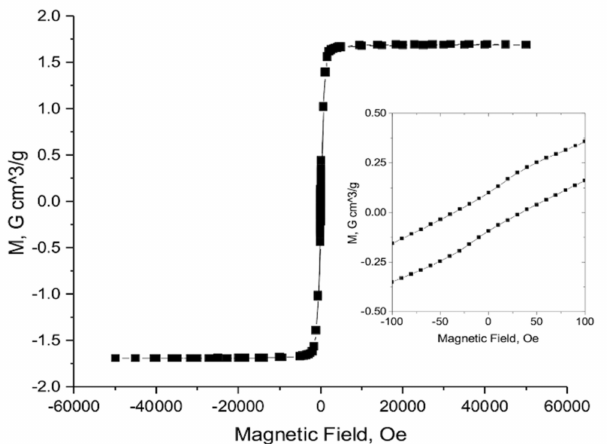
Figure 4. Magnetic-field dependence of the magnetization of the object 3D-printed from the pho- topolymer composition with 5 wt.% of ZIF-8 and 5 wt.% of Ni-BTC. Inset: the magnetic hysteresis loop in the magnetic fields between − 100 and 100